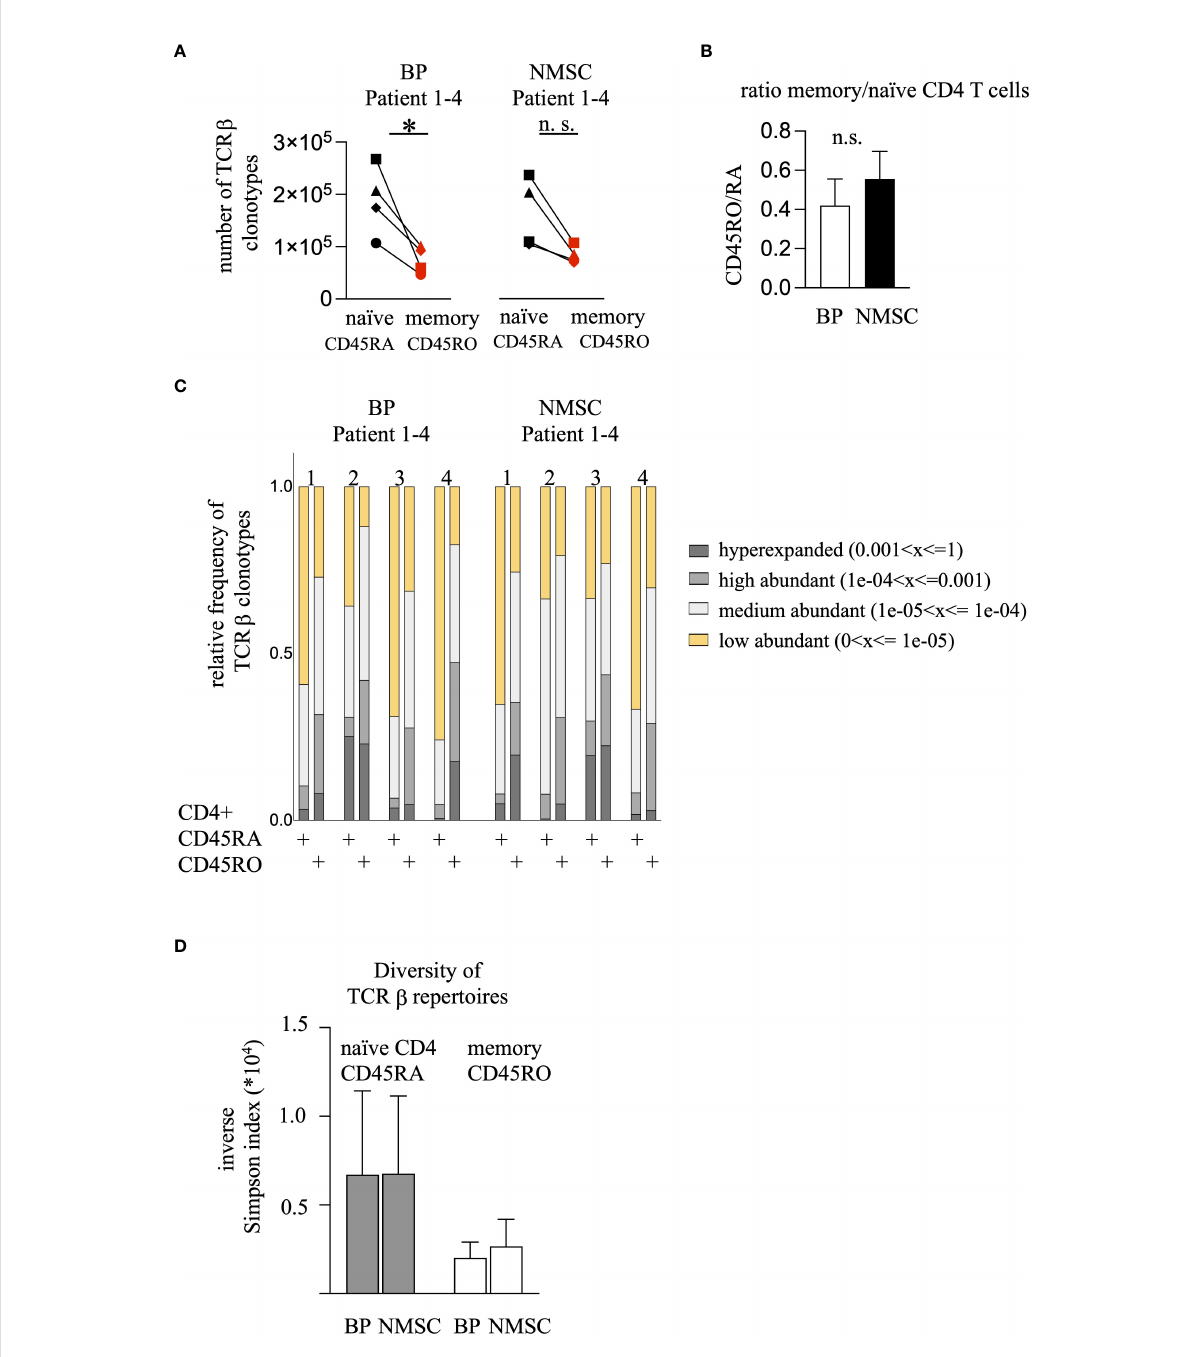
FIGURE 2 BP patients harbor fewer CD45RO clonotypes but the frequency of the high-abundant TCR b clonotypes do not differ compared to the NMSC patients. (A) The numbers of the unique TCR b clonotypes from the CD45RA (black symbols) and CD45RO (red symbols) CD4 T cell population are shown. The values obtained from the same patient are connected. (n = 4, *p<0.05, One-way ANOVA with turkeys ’ multiple comparison test). (B) The ratio of the unique TCR b clonotypes from the CD45RO/RA population was calculated. Data are mean ± SEM. No signi fi cant difference between BP and NMSC patients was found. (n = 4, Mann-Whitney test). (C) The clonal distribution of the TCR b clonotypes is shown. TCR b clonotypes were divided regarding their clonal abundance. Each bar represents the clonotypes of the CD45RA and CD45RO population from one patient. Each bar is divided into 4 sections. Each section represents the fraction of clonotypes that exist at a certain frequency (yellow: > 1 x 10 -5 , bright gray: 1 x 10 -5 - 1 x 10 -4 , gray: 1 x 10 -4 - 1 x 10 -3 , dark gray: < 1 x 10 -3 ). (D) Inverse Simpson Index shows no difference between the BP or NMSC patients. (Data are mean ± SEM, gray bars: CD45RA, white bars: CD45RO no signi fi cance, 2-way